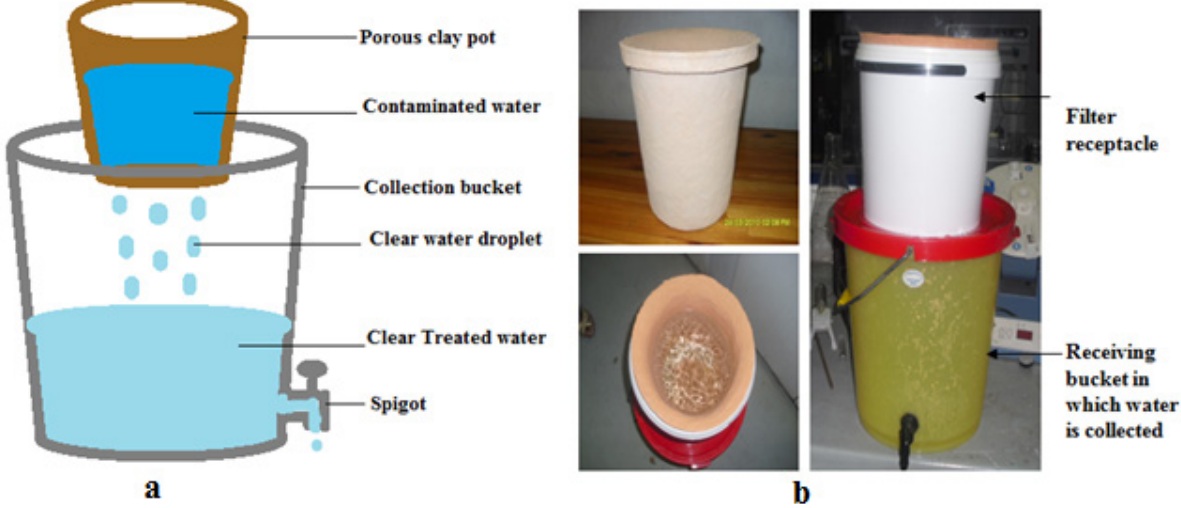
Figure 5. ( a ) Schematic diagram and ( b ) photograph of silver-impregnated porous pot filter.